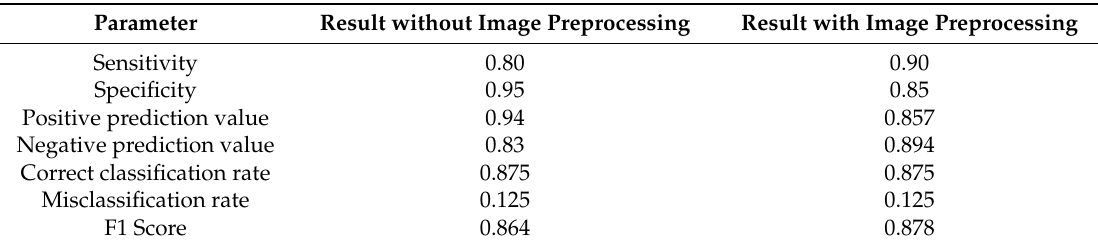
Table 2. Statistical evaluation results of classification algorithm via test dataset.